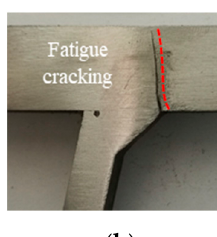
Figure 4. Sectional view of the prototype bridge (Unit: mm). Since the prototype bridge is on a major urban expressway with heavy traffic volume and a high proportion of trucks, the fatigue damage will accumulate with the time of operation and gradually lead to cracking in the RD joints. To this end, the OSD with TEUs have been applied in the design to prevent premature fatigue cracking in the joints. Investigations will be performed on